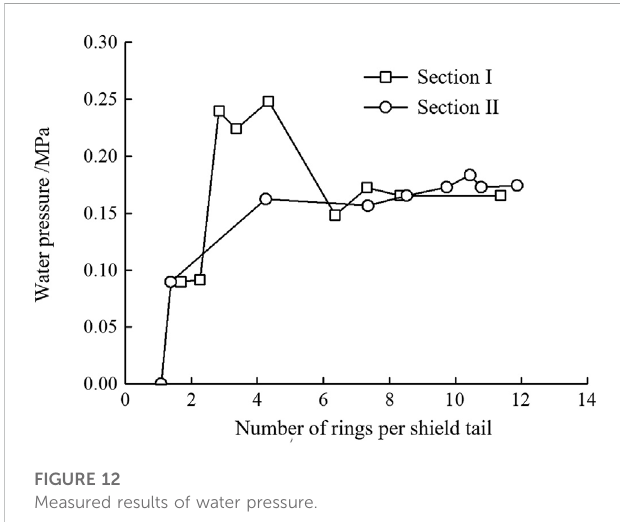
FIGURE 12 Measured results of water pressure.